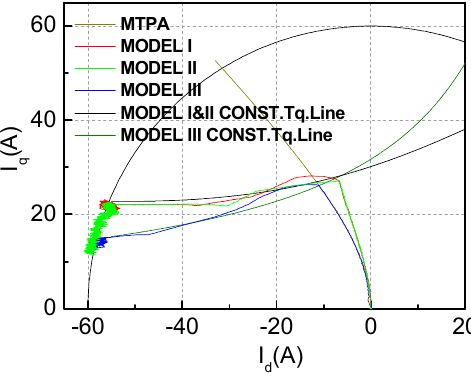
Figure 10. The current trajectory when torque command is restricted at 90 Nm.